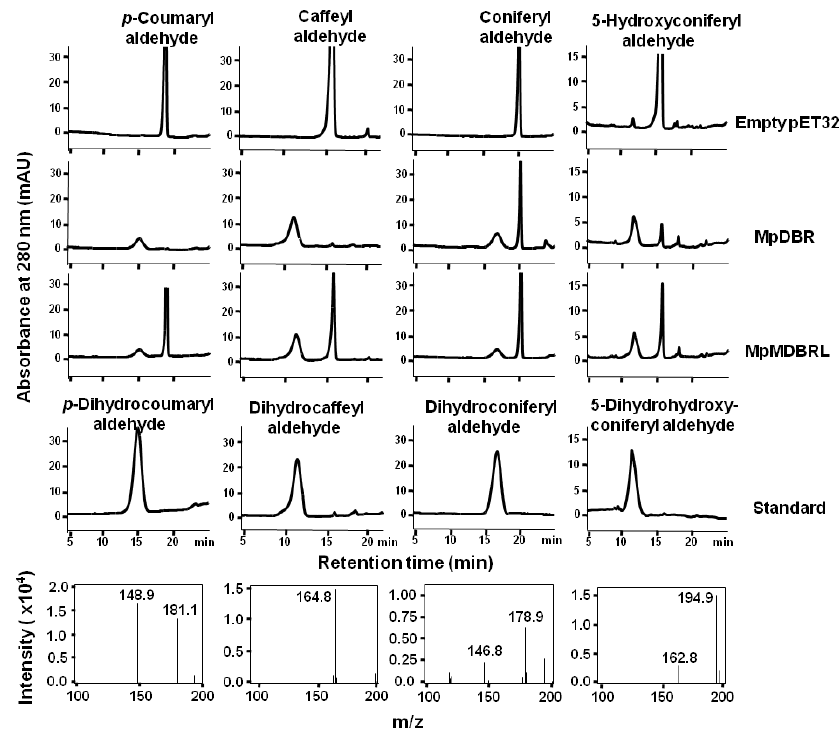
Figure 3. The HPLC profiles and MS spectra of reaction products generated by recombinant DBRs. The activities of recombinant DBRs when provided with either p -coumaryl, caffeyl, coniferyl, or 5-hydroxyconiferyl aldehyde as a substrate. The MS spectra of the MpDBR reaction products are shown in the lower panel. Negative ionization mode was used.